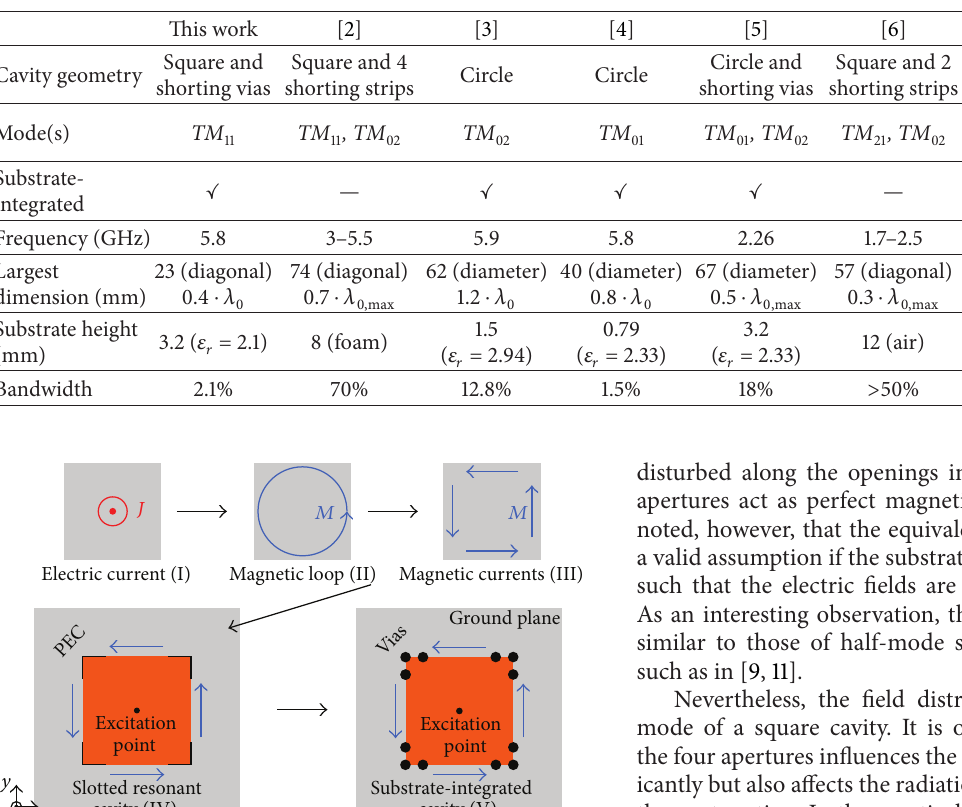
Table 1: Comparison of different low-profile monopole patch antennas from the literature.